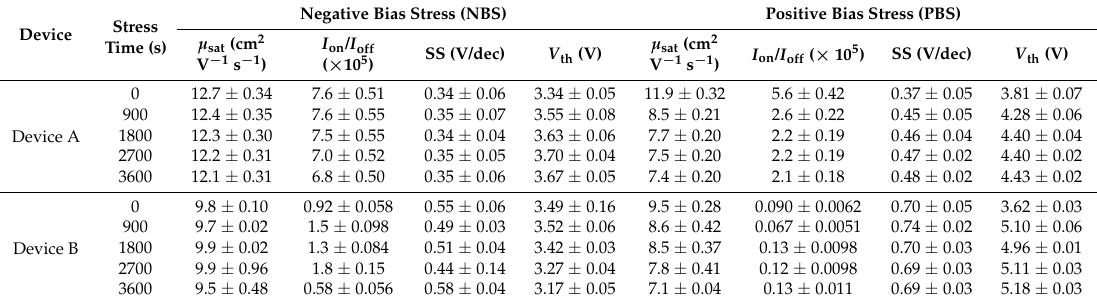
Table 2. Electrical characteristics of the devices. Device A: The TFTs with the ZrO 2 films obtained by spin-coating with 0.3 M precursor for 6 times. Device B: The TFTs with the ZrO 2 films obtained by spin-coating with 0.6 M precursor for 3